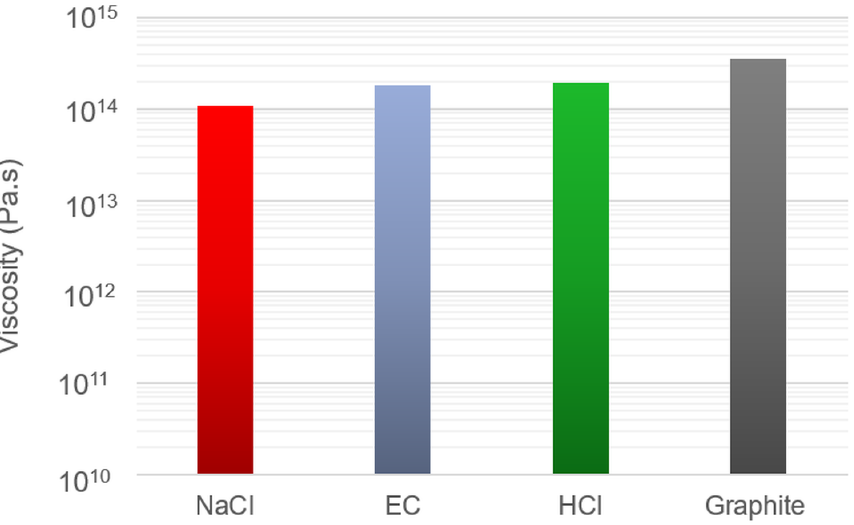
Figure 8. Viscosity of free-standing YSZ coatings determined by three-point bending experiments. See Table 1 for the details of different substrate removal methods.